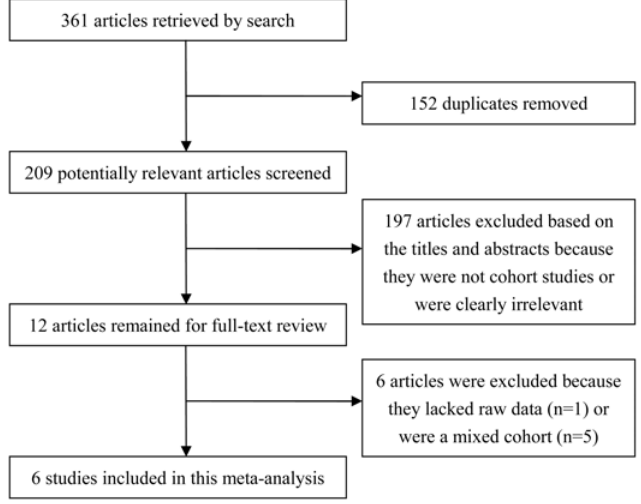
Fig 1. Flow chart of the assessment and selection of publications for the